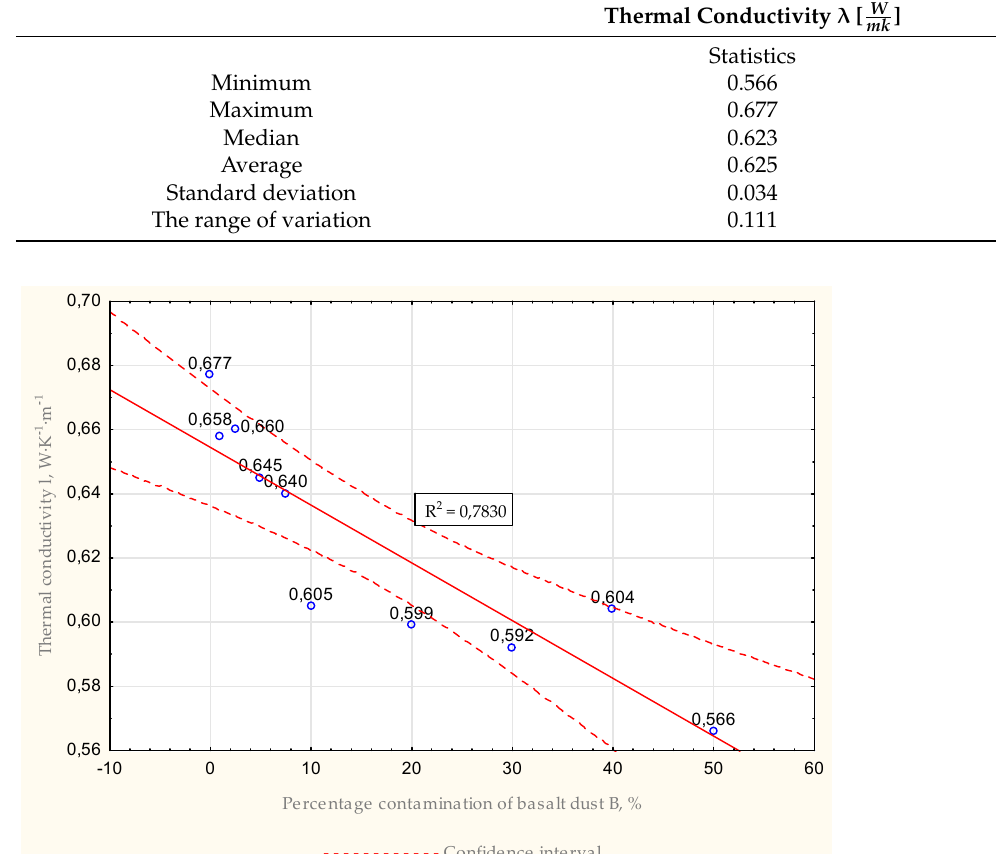
Table 9. Average thermal conductivity for basalt dust B for all samples for water − mix ratio = 0.6.